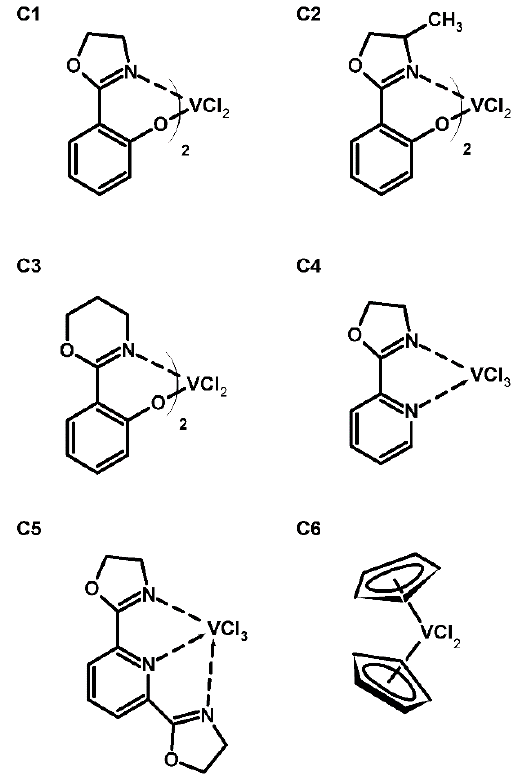
Figure 1. Structures of the vanadium complexes applied for E-NB copolymerization.